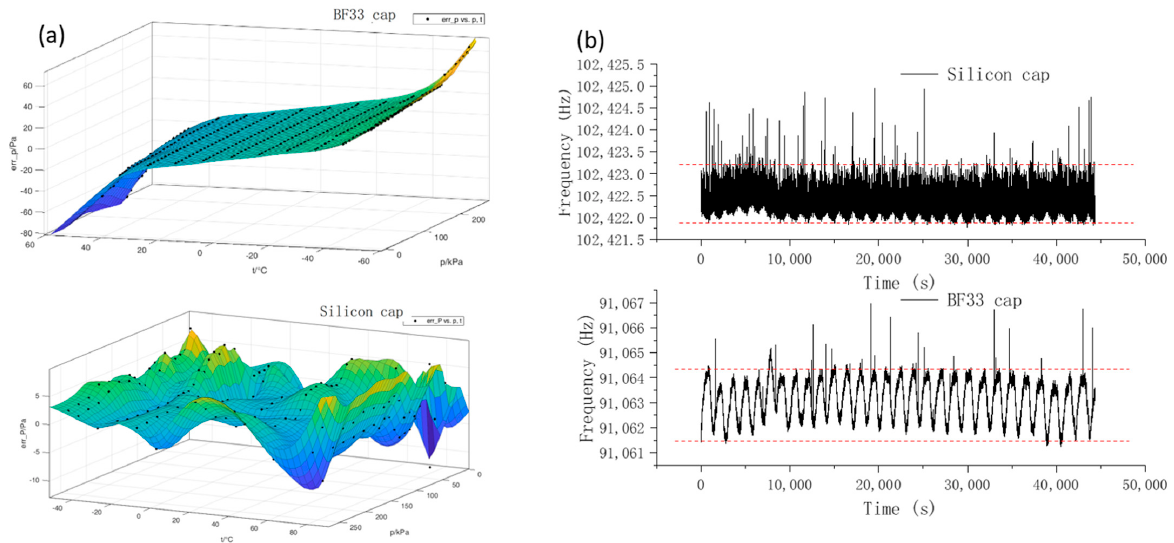
Figure 6. Accuracy ( a ) and stability ( b ) of the pressure-sensitive microsensors with glass or silicon caps. con